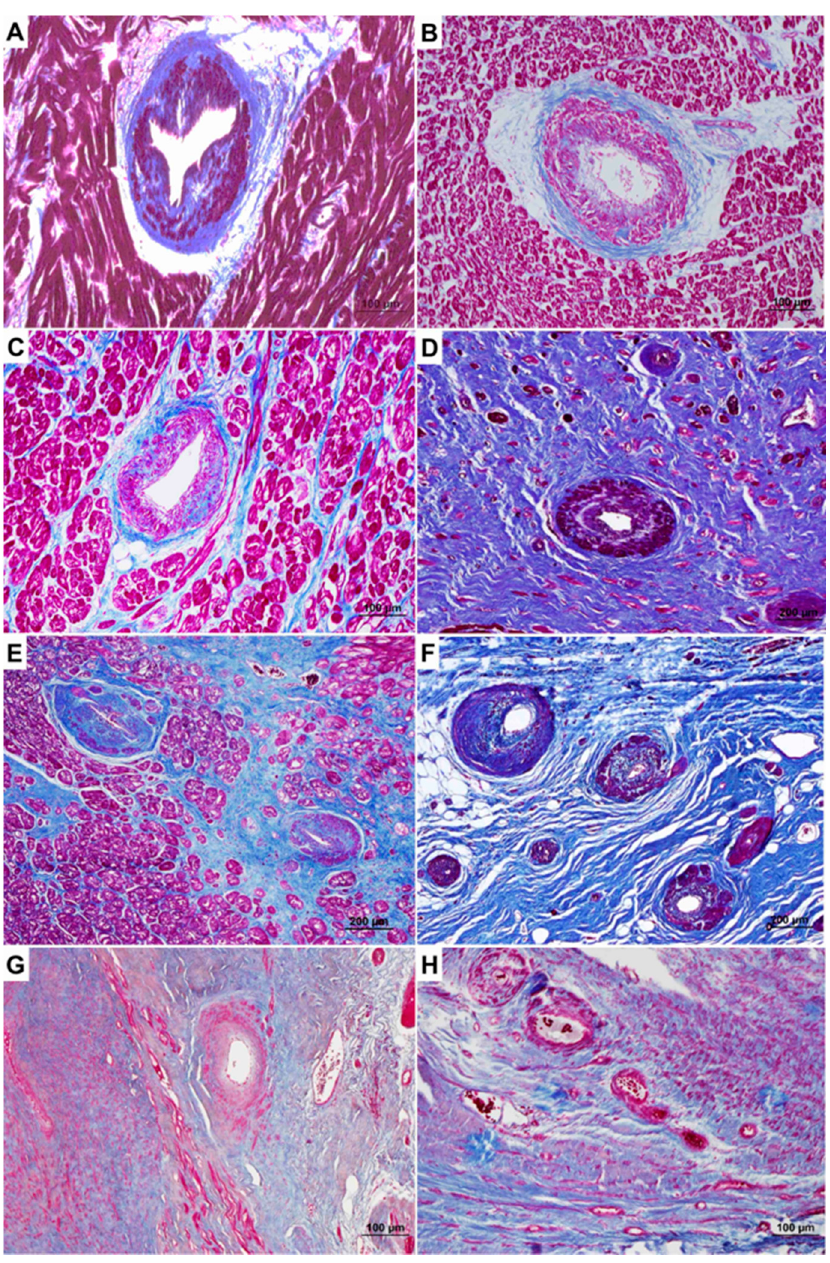
Figure 4. SVD in the study population: exemplificative histological features in the various subgroups. ( A , B ) SCD-HCM patient with SVD in the absence of replacement-type fibrosis. ( C , D ) SCD-HCM patient with SVD in areas without ( C ) and with ( D ) fibrosis: note the higher score in the area with replacement-type fibrosis. ( E , F ) HF-HCM patient with SVD in areas without ( E ) and with ( F ) fibrosis. ( G , H ) IHD patient showing large areas of replacement-type fibrosis with SVD, with a lower score as compared to HCM cases. ( A – H ) Heidenhain trichrome.